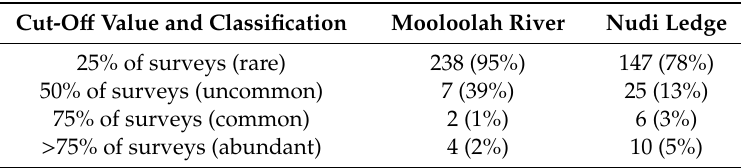
Table 3. Revised cut-o ff values for measures of temporal rarity, including number of species falling into each category and their percentage (rounded to whole number) of the total species